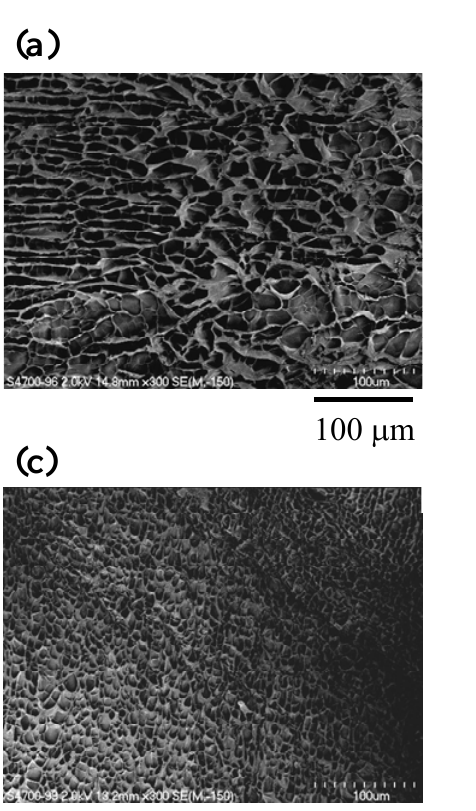
Figure 3. SEM photographs of lyophilized composite gels: ( a ) FG20; ( b ) FG20-Imo0.2; ( c ) FG20-Imo0.6; and ( d ) FG20-Imo2.0.